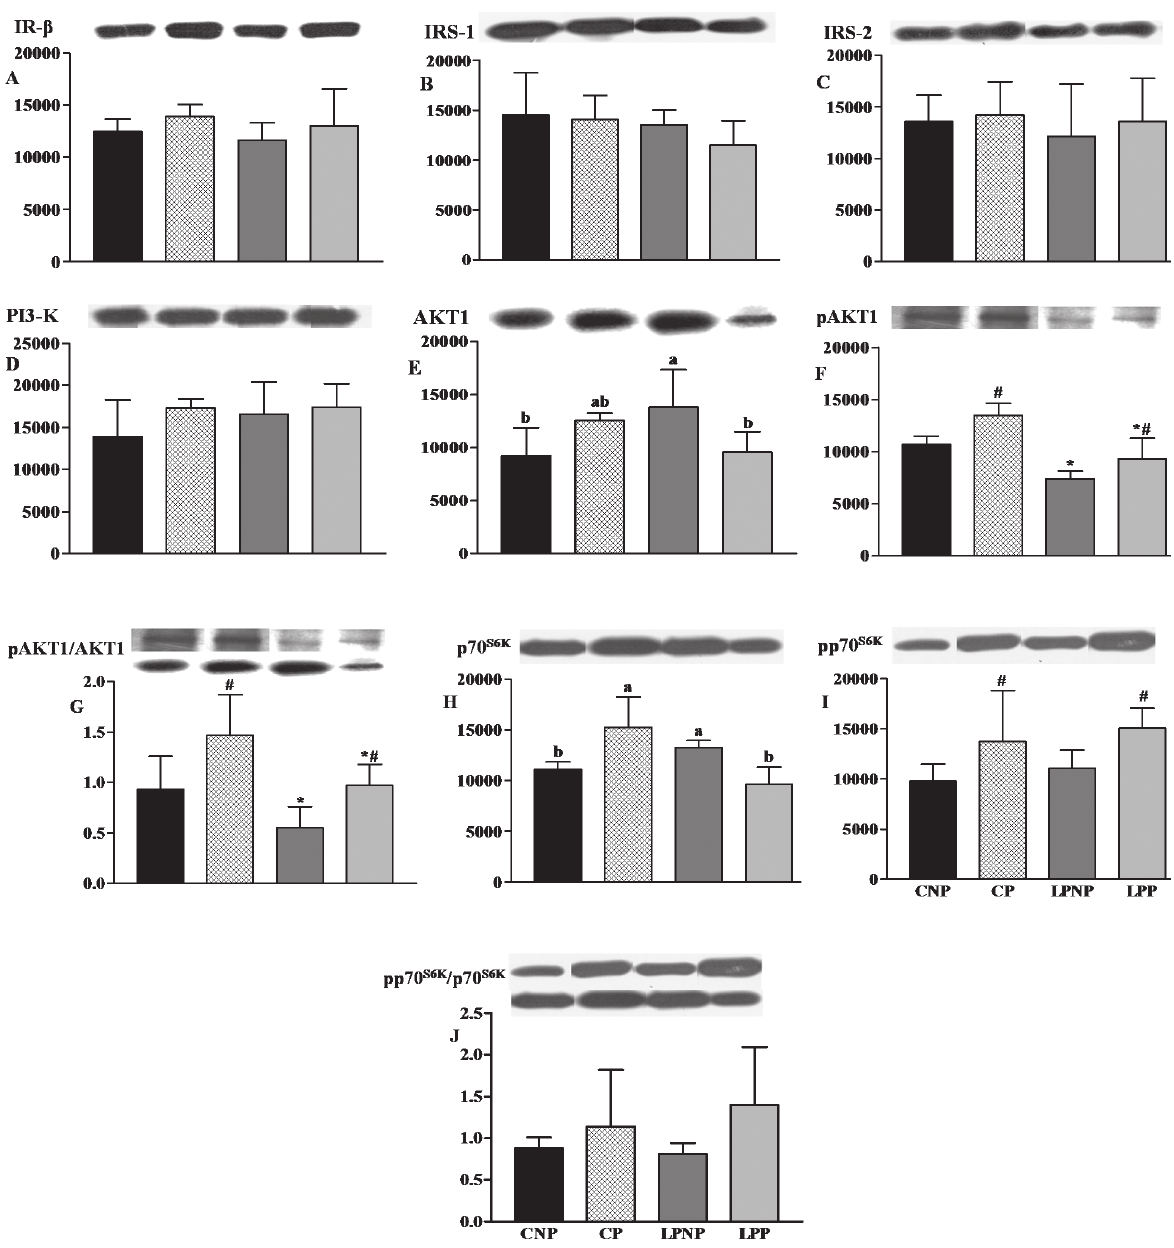
Figure 1 - Protein expression of IR-β (A), IRS-1 (B), IRS-2 (C), the p85 subunit of PI3K (D) and AKT1 (E), phospho- [Se473] AKT1 levels (F), phospho- [Se473] AKT1/AKT1 ratios (G), the protein expression of p70 S6K (H), phospho-p70 S6K levels (I) and phospho-p70 S6K /p70 S6K ratios (J) in the islets of CNP, CP, LPNP and LPP rats. Equal amounts of protein (60 µg) were subjected to immunoprecipitation using antibodies anti-IRβ , anti-IRS1, anti-IRS2, anti-PI3K-p85, anti-p70 S6K , or anti-phospho p70 S6 . Immunoprecipitates were analyzed by SDS-PAGE followed by immunoblotting with antibodies to IR-β, IRS-1 IRS-2, PI3K-p85, p70 S6K and phospho-p70 S6K . Equal amounts of protein (50 µg) were run on SDS-PAGE and blotted with anti-AKT1 and anti- phospho- [Se473] AKT1. The columns represent the means ± SDs of 3-6 independent experiments. # Indicates difference in relation to non-pregnant rats (Two-way ANOVA, P <0.05). *Indicates differences in relation to rats maintained on a control diet (Two-way ANOVA, P <0.05). a,b Mean values with unlike superscript letters were significantly different (LSD test; P